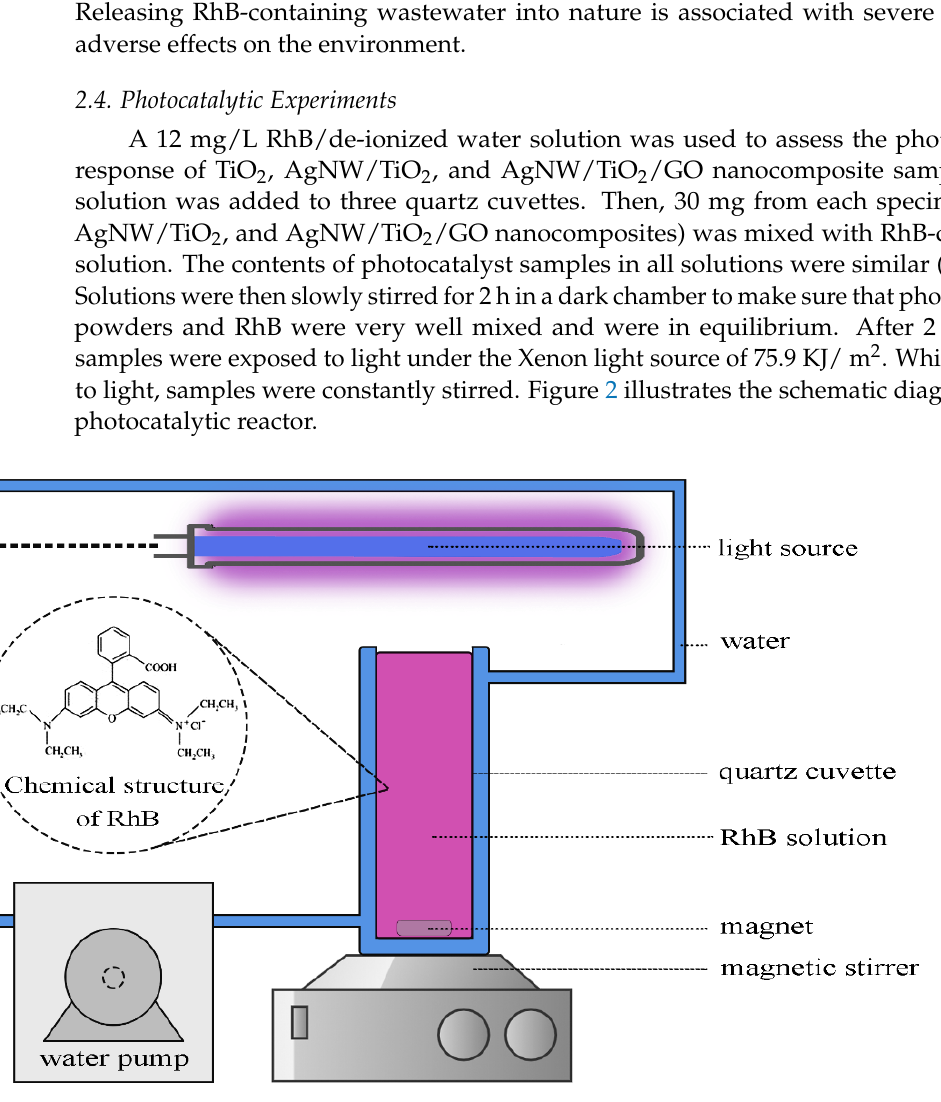
Figure 2. Schematic diagram of the photocatalytic reactor.